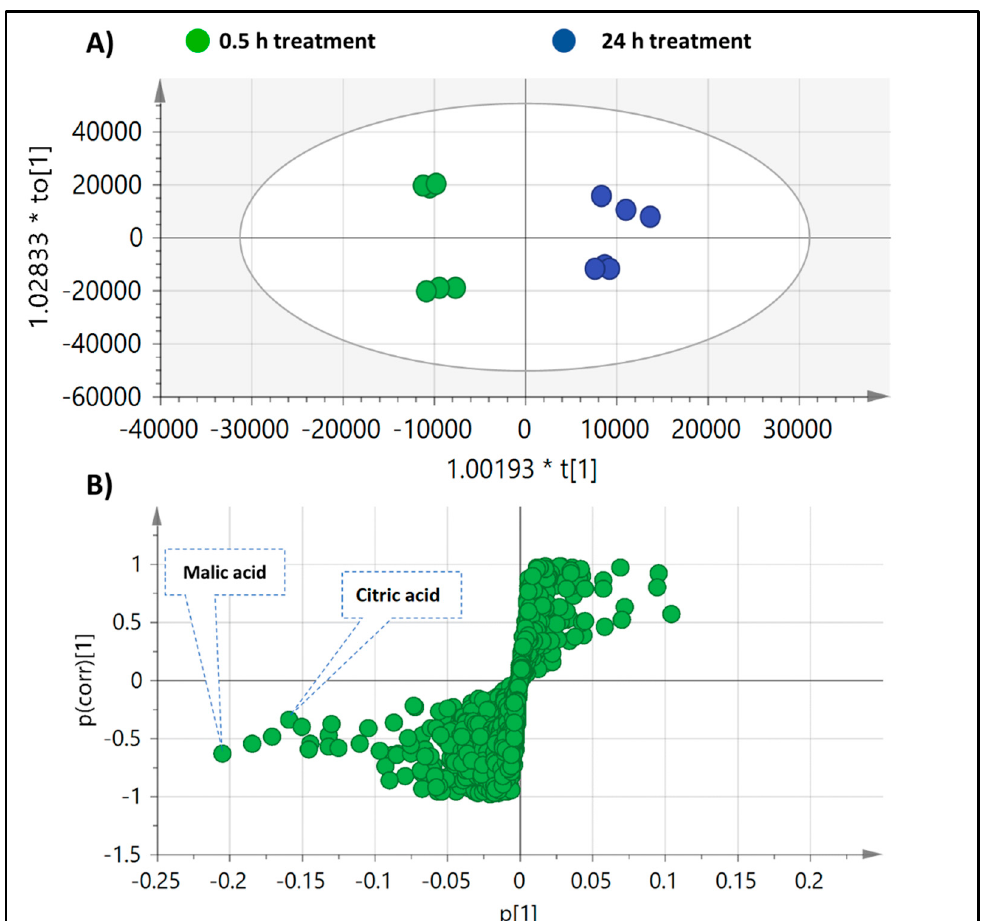
Figure 5. ( A ) OPLS model of O. ficus in vitro treated with gut microbiota based on incubation time; 24 h treatment samples (blue) modeled against 0.5 h (green). ( B ) S ‐ plot of OPLS model, where metabolites with negative p values showed an increased abundance with 0.5 treatment samples, mainly malic and citric acid.